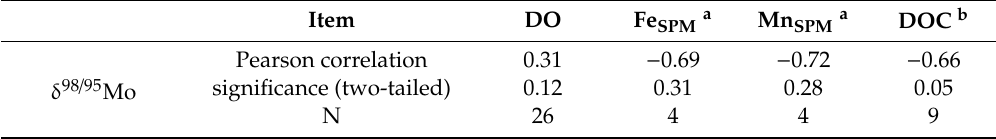
Table 2. The correlation between δ 98 / 95 Mo, DO, Fe SPM , Mn SPM , and DOC for upper Xijiang River water. Item DO Fe SPM a Mn SPM a DOC b Pearson correlation 0.31 − 0.69 − 0.72 − 0.66 significance (two-tailed) 0.12 0.31 0.28 0.05 δ 98 / 95 Mo N 26 4 4